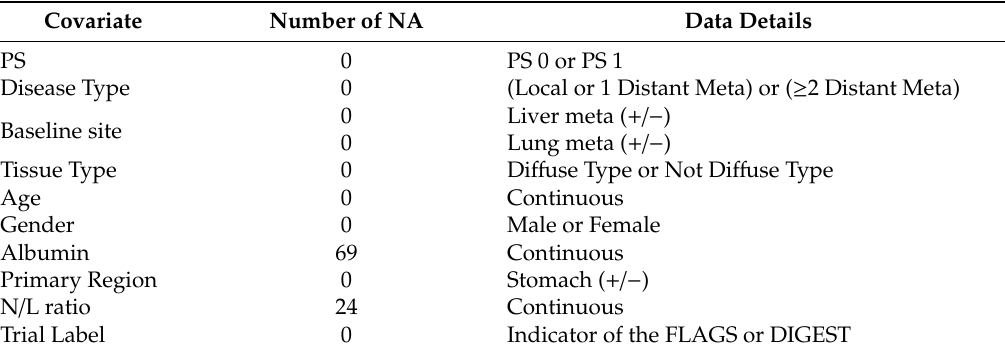
Table 1. Re-selection of the clinico-pathological factors in FLAGS and DIGEST trial.